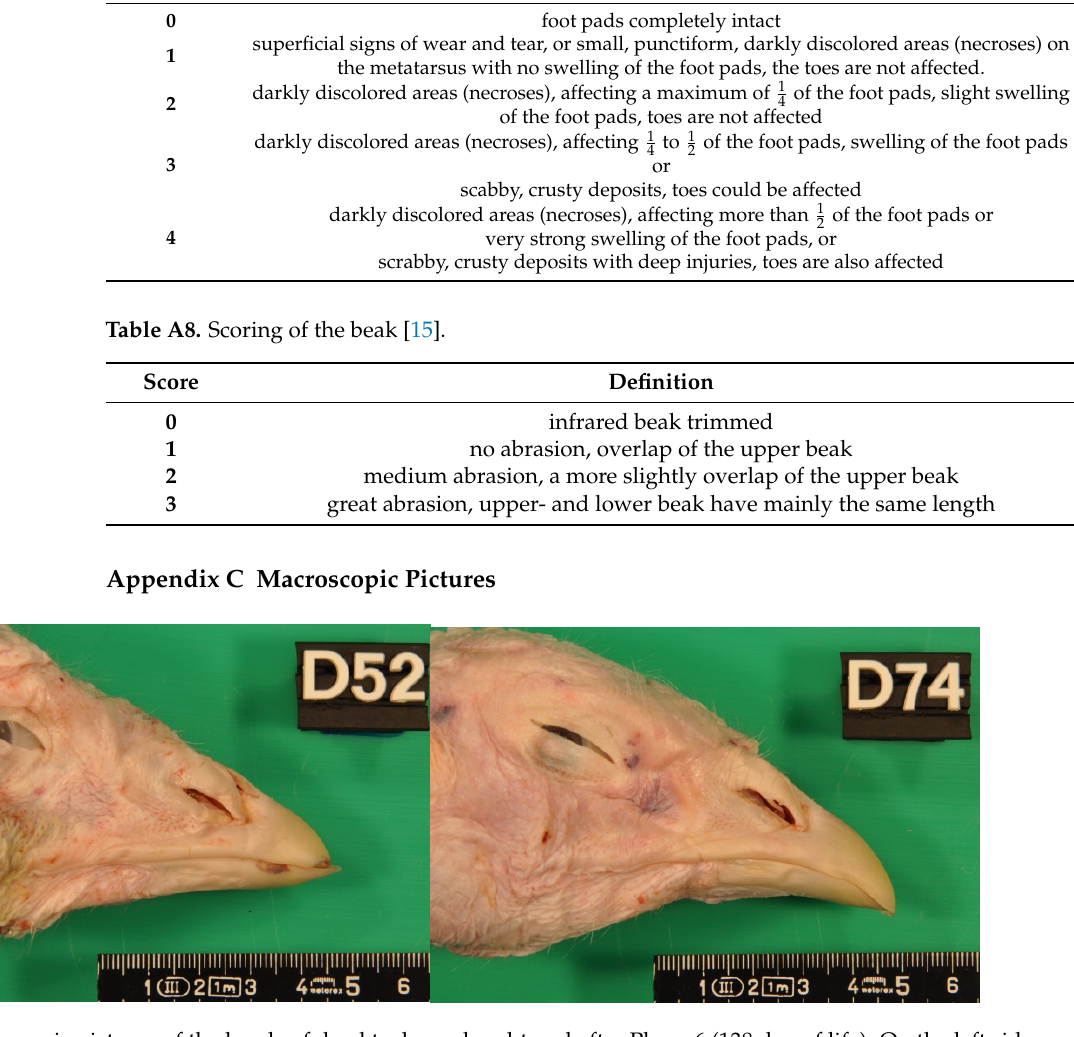
Figure A1. Macroscopic pictures of the heads of dead turkeys slaughtered after Phase 6 (138 day of life). On the left side (D52) is an infrared beak trimmed turkey and on the right side (D74) is the head of a turkey which had an integrated screed grinding wheel in the feed pan.